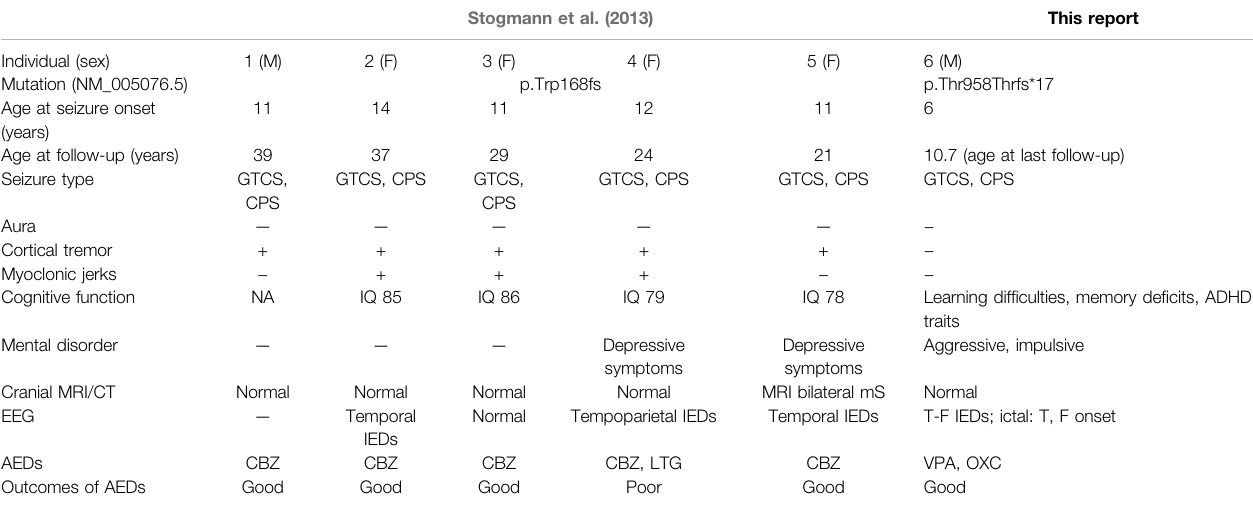
TABLE 1 | Summary of CNTN2 mutations and main clinical features.